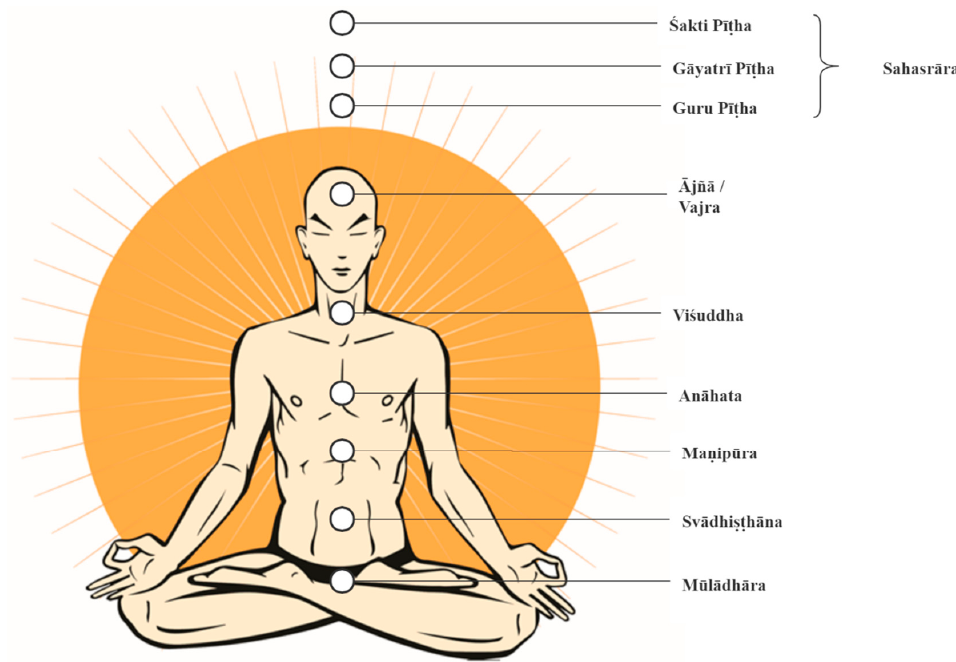
Figure 1. The cakras according to Samay¯ac¯ara ´Sr¯ıvidy¯a of Figure 1. The cakra s according to Samay ā c ā ra Ś r ī vidy ā of Lalit ā mbik ā . In the scriptures of Ś r ī vidy ā (e.g., Varivasy ā rahasya 2.92), the section on bh ū pura is